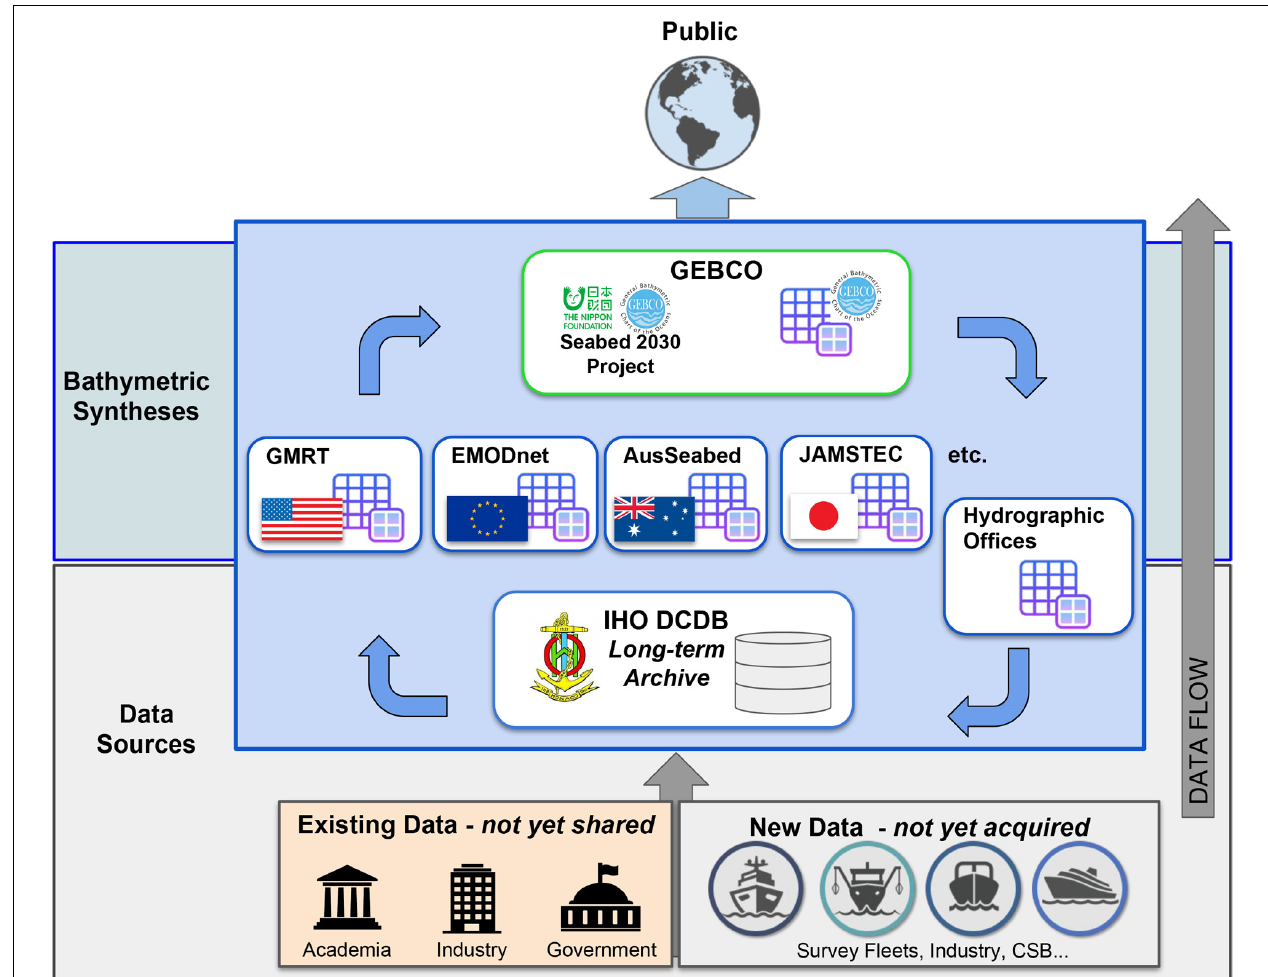
FIGURE 7 | Schematic showing overall flow of data from academic, public and industry sources into public repositories and bathymetric synthesis efforts. This diagram highlights some of the efforts that are underway globally, but is not an exhaustive list of all projects and scales of coordination.